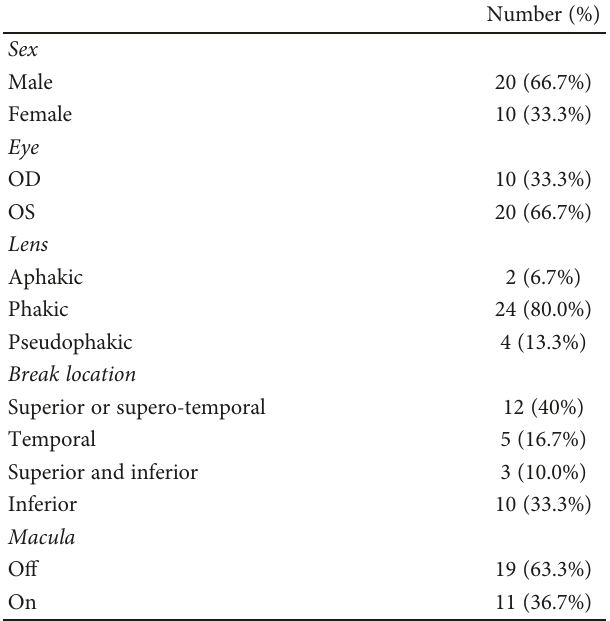
Table 1: Distribution of the studied cases according to demographic and clinical characteristics.